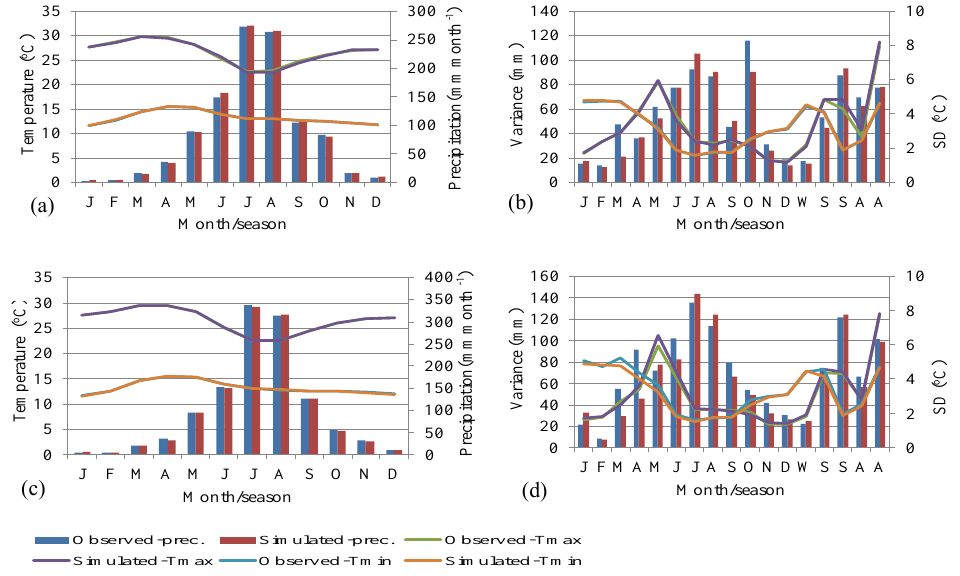
Figure 6. Calibration of observed and simulated of precipitation, maximum temperature and minimum temperature for the Gondar station using SDSM from canESM2 and HadCM3 from (a, b) to (c, d) .